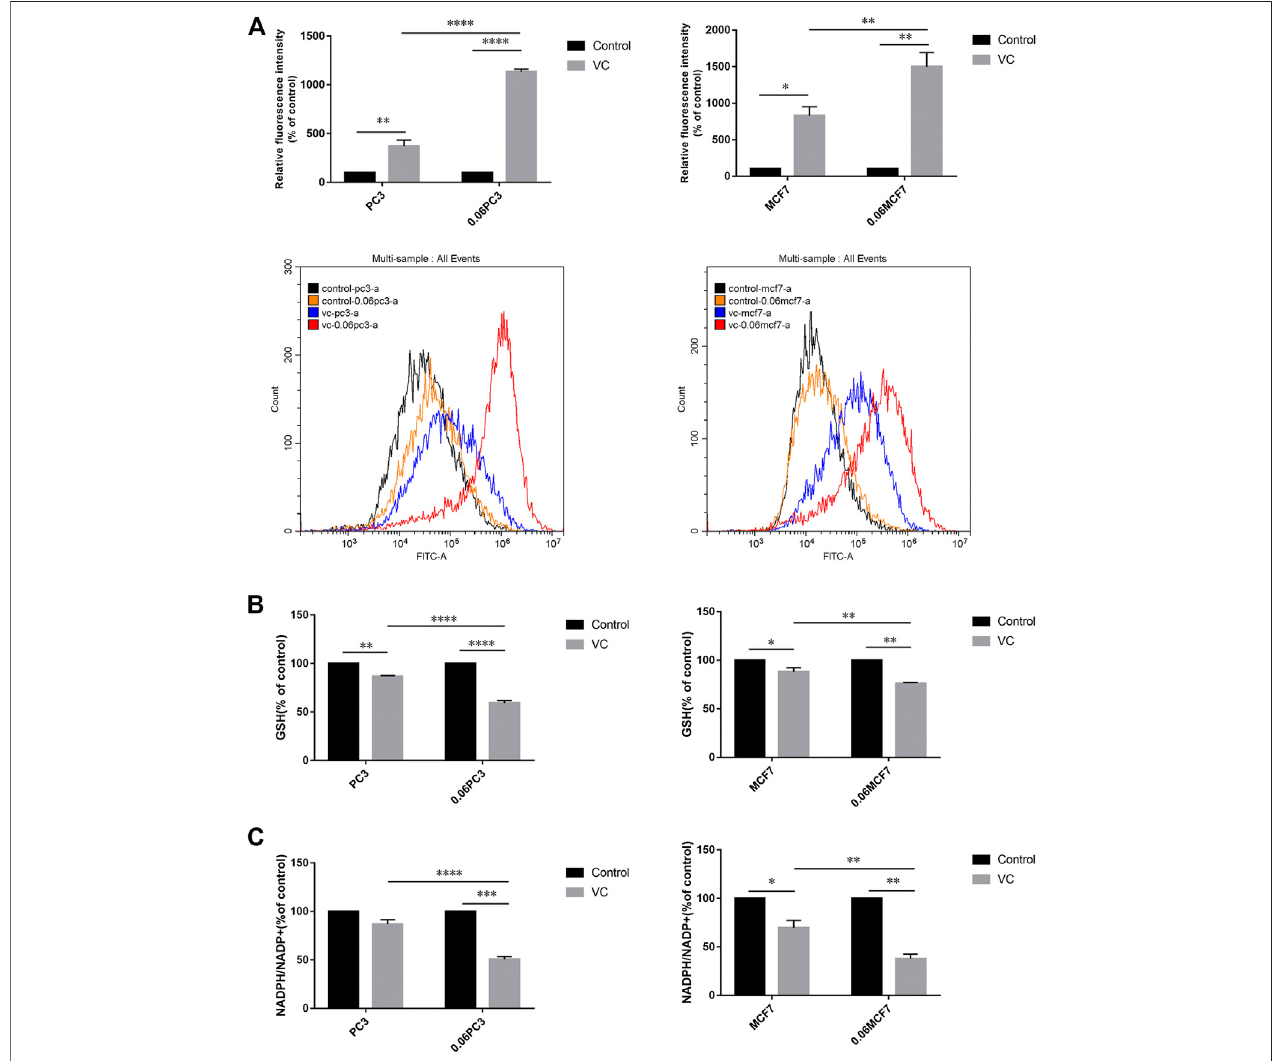
FIGURE 4 | Cancer cells overexpressing GS show augmented redox imbalance under VC treatment. (A) Quantitative bar graphs ofcelllular ROS levels before and aftertreatmentwithVC(8mM,3h). (B) QuantitativebargraphsofcelllularGSHlevelsbeforeandaftertreatmentwithVC(8mM,3h). (C) Quantitativebargraphsofcelllular NADPH/NADP + ratio before and after treatment with VC (8mM, 3 h). All data are presented as means ± SEM, * p < 0.05, ** p < 0.01, *** p < 0.001, **** p < 0.0001, n (cid:2) 3. VC, Vitamin